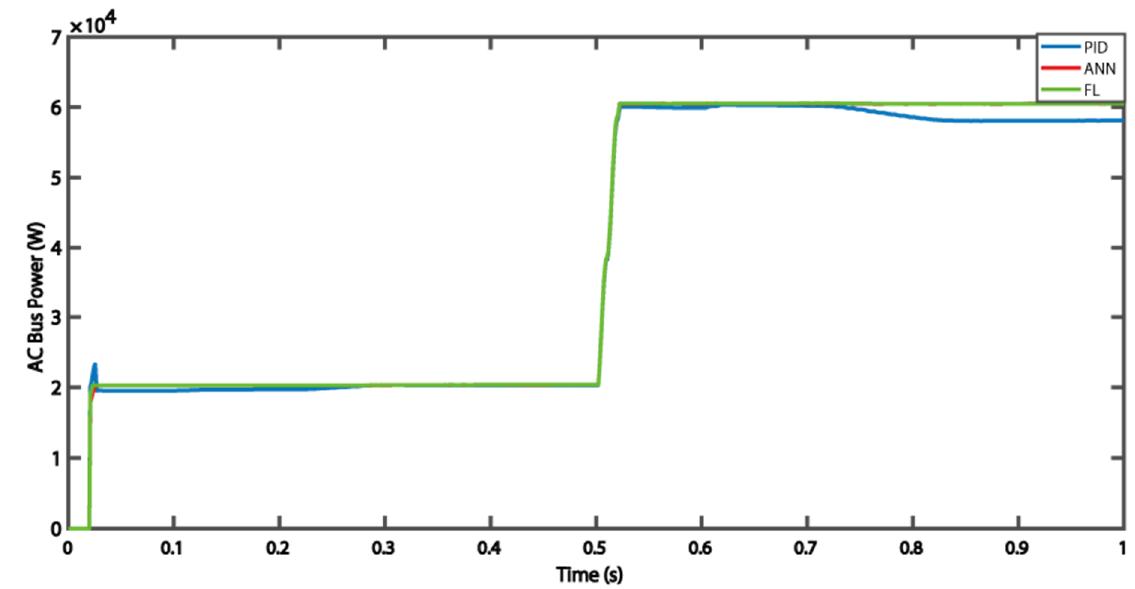
Figure 22. Measured power at the AC bus (W).